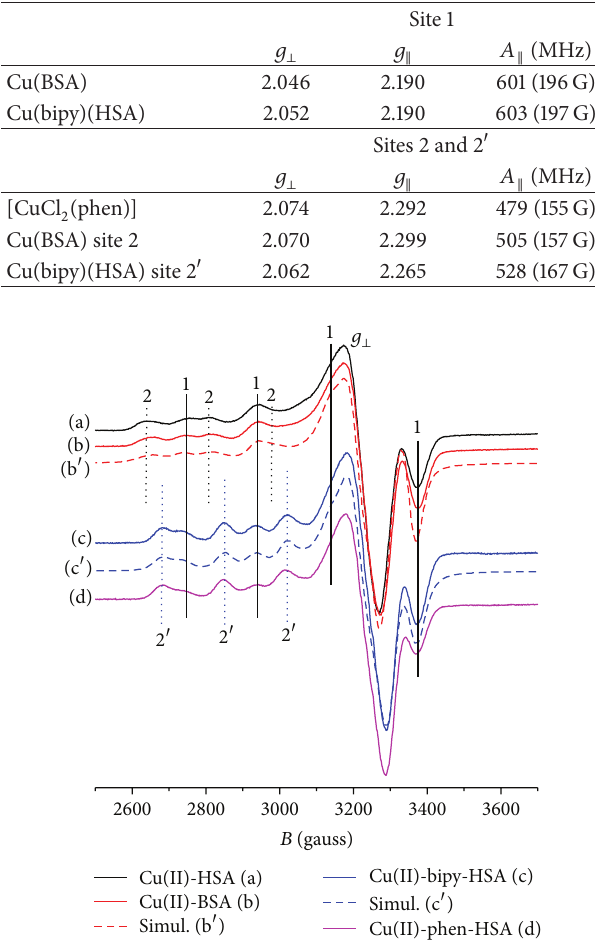
Figure 6: X-band EPR spectra for HSA and BSA Cu(II) complexes ((a) and (b), resp.) and for Cu(II)-bipy and Cu(II)-phen complexes with HSA ((c) and (d), resp.). Experimental conditions: Cu, HSA, and BSA 0.5 mM, phosphate buffer 20 mM, and pH 7.4, at 77 K. (b 󸀠 ) and (c 󸀠 ) are the simulated spectra of (b) and (c), using EasySpin [20] with parameters in Table 4.